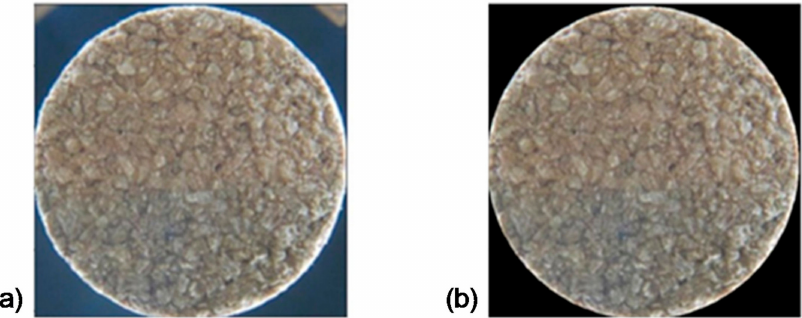
Figure 1. Pre-processed image: ( a ) before the cropping operation; ( b ) after the cropping operation.